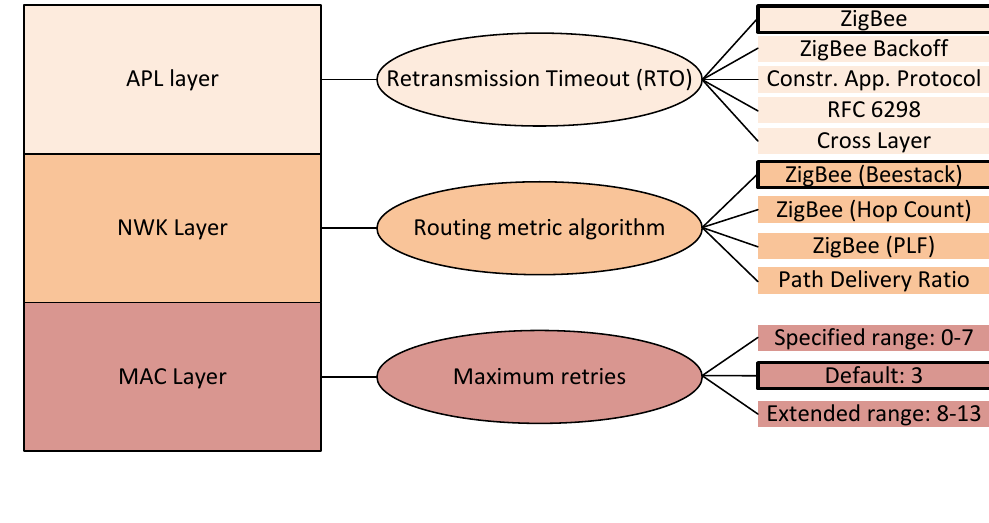
Figure 1. Simplified overview of the ZigBee communication protocol stack and the parameters/mechanisms that are evaluated from different layers and the default and alternative settings for these parameters/mechanisms. The default settings are highlighted with bolded